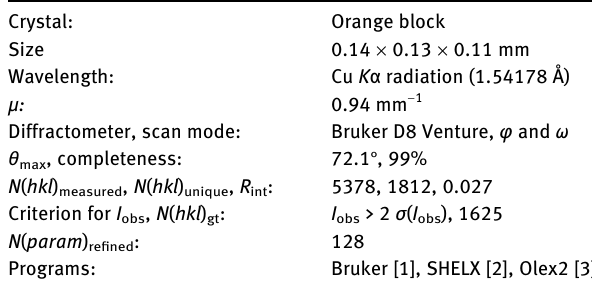
Table 1 contains crystallographic data and Table 2 contains the list of the atoms including atomic coordinates and displacement parameters.